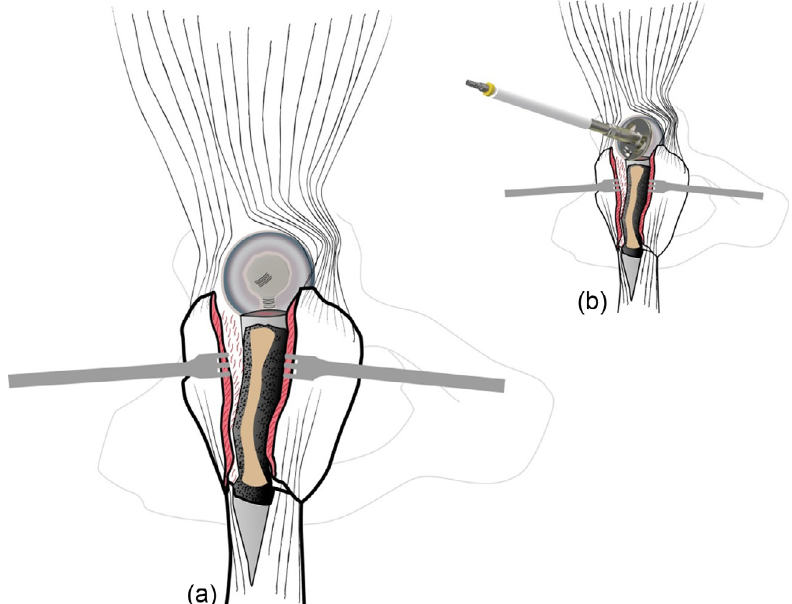
Figure 6. (a) Good exposure of the acetabulum after head removal, (b) reaming.